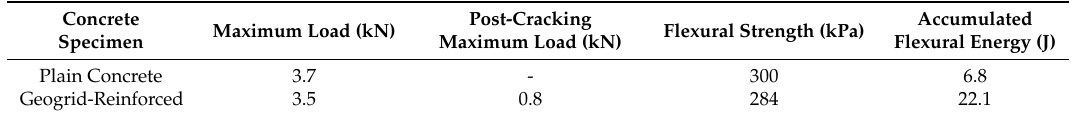
Table 3. Results of flexural tests on concrete